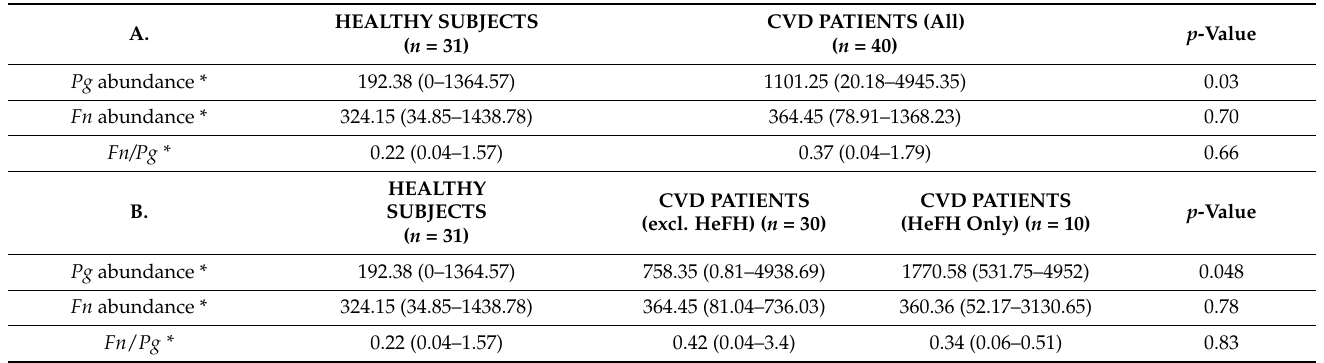
Table 2. Pg and Fn abundance: Comparison between healthy subjects and ( A ) all patients with previously diagnosed CVD, and ( B ) with the non-HeFH subgroup and the HeFH